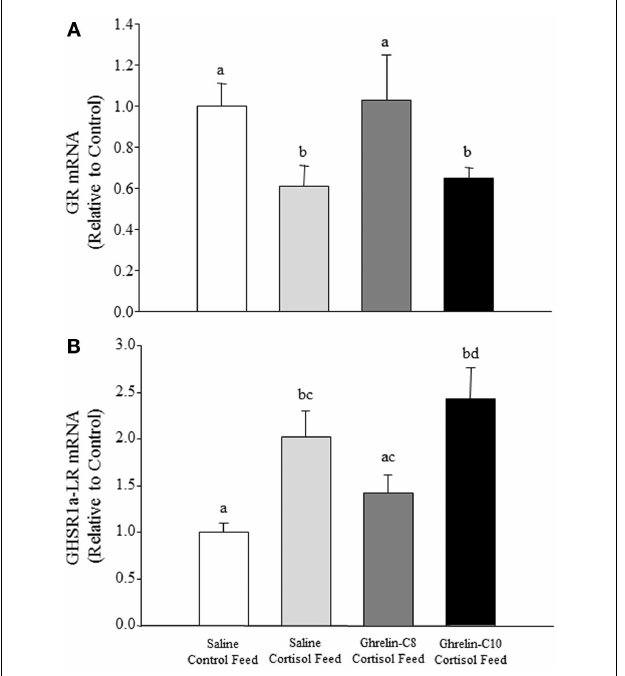
FIGURE 1 | Sexually mature male and female tilapia were surgically implanted with a micro-osmotic pump into the IP cavity containing either saline (control), 100 µ g/ml of ghrelin-C8, or 100 µ g/ml of ghrelin-C10 (34). The calculated rate of release at 24°C was 13ng/h for 32days.Twenty-four hours following the surgery fish were fed a control diet or cortisol-laden feed [500mg/kg feed; (48)] for 21days twice a day. Upon termination of the experiment brain sections were collected, RNA was extracted and reversed transcribed into cDNA. Relative mRNA expression levels were determined by qPCR. Ghrelin-C8 treatment significantly reversed the inhibitory effects of cortisol on GR mRNA expression levels in the hypothalamus (A) . Ghrelin-C8 treatment partially reversed the stimulatory effect cortisol exhibited on hypothalamic GHS-R-1a-LR mRNA expression levels (B) . mRNA data are presented as relative to saline control feed group. Columns with different letters are significantly different at P < 0.05, n =